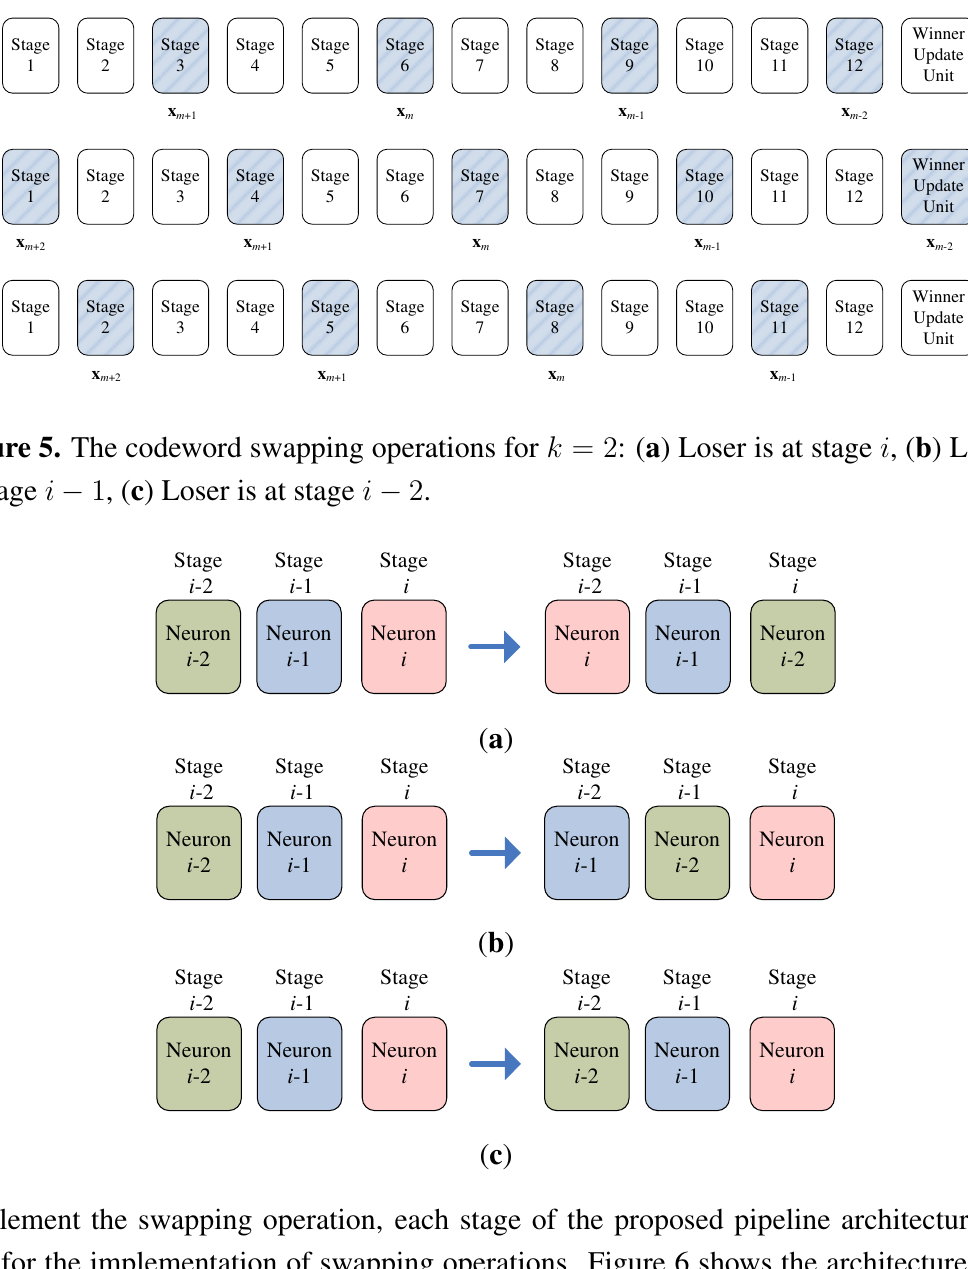
Figure 4. Snap shots of the proposed pipeline architecture with N = 12 and k = 2 , where shaded stages are the stages occupied by a training vector, and unshaded stages are the vacant stages.